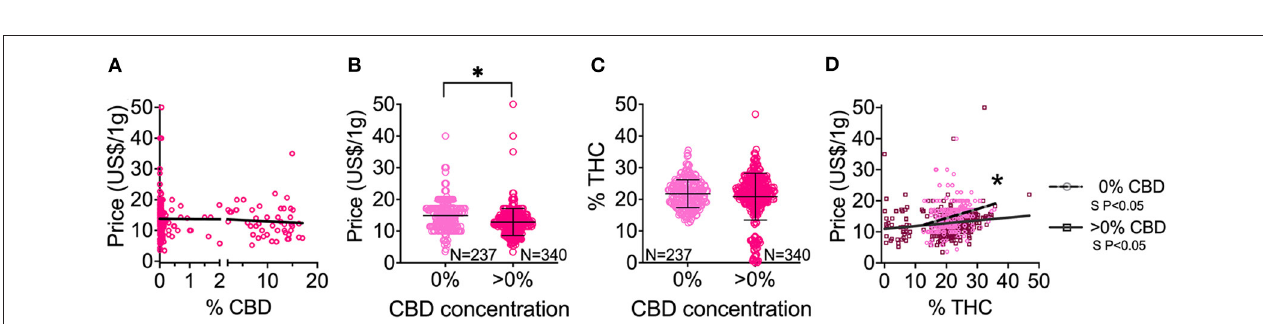
FIGURE 3 | THC content and price of cannabis herbal products by chemovar. (A) Comparison of THC content (%) among Sativa, Indica, and Hybrid herbal products (flower and preroll). (D) Comparison of price (US $) among Sativa, Indica, and Hybrid herbal products (flower and preroll). (A) THC and price correlation of Sativa herbal products. (B) THC and price correlation of Indica herbal products. (C) THC and price correlation of Hybrid herbal products. * P < 0.05, between linked groups by one-way ANOVA, Tukey’s posttest (A,B) . Data shown as mean ± SD (A,B) . S P < 0.05 denotes significantly non-zero slopes (C–E) .